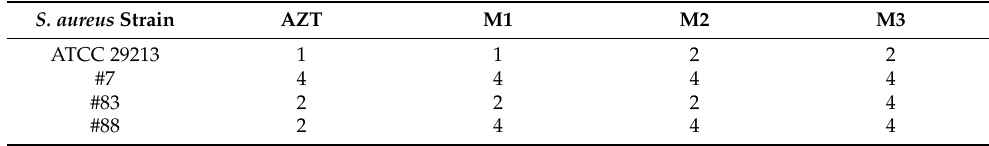
Table 3. MIC ( µ g/mL) of free AZT and loaded microemulsions against S. aureus